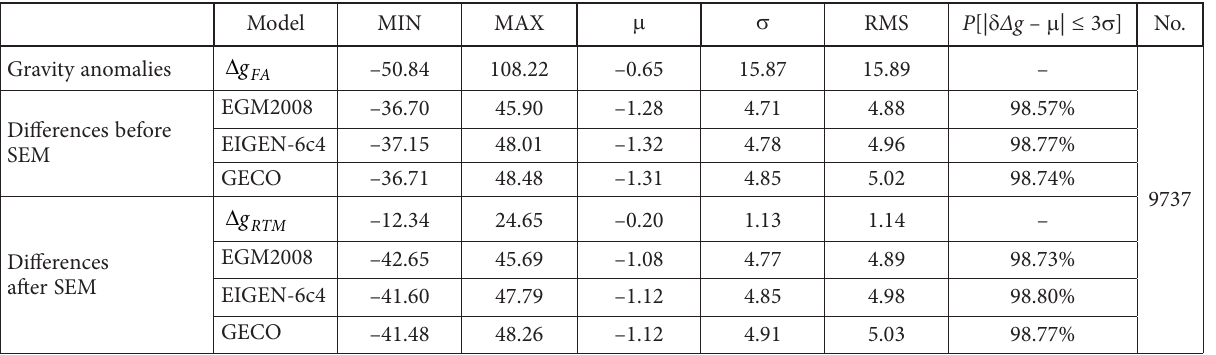
Table 2. Statistics of differences between terrestrial gravity data and combined GGMs at d/o 2190 (in mGal)